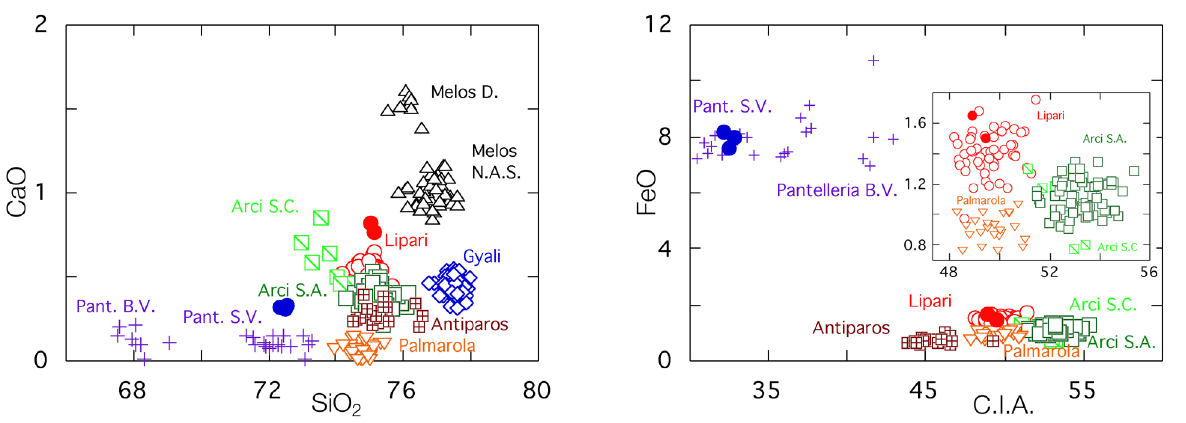
Figure 6: Plots of the SEM-EDS chemical analyses of the glass of 5 samples (1, 16, 97, 112 and 115) of the Casa dei Francesi obsidians whose provenance was not exactly determined by WD-XRF: two samples reveal provenance from Lipari (USFRA 16 and 97, red points) and the other three from Pantelleria S.V. (USFRA 1, 112 and 115, blue points). Each plotted value represents the mean of at least three ED microanalyses. The literature data on different geological obsidian sources of the Mediterranean basin are from Acquafredda et al. (1999, 2019). Sub- sources outcrops abbreviations as in Figure 5. C.I.A. = Chemical Index of alteration [Al